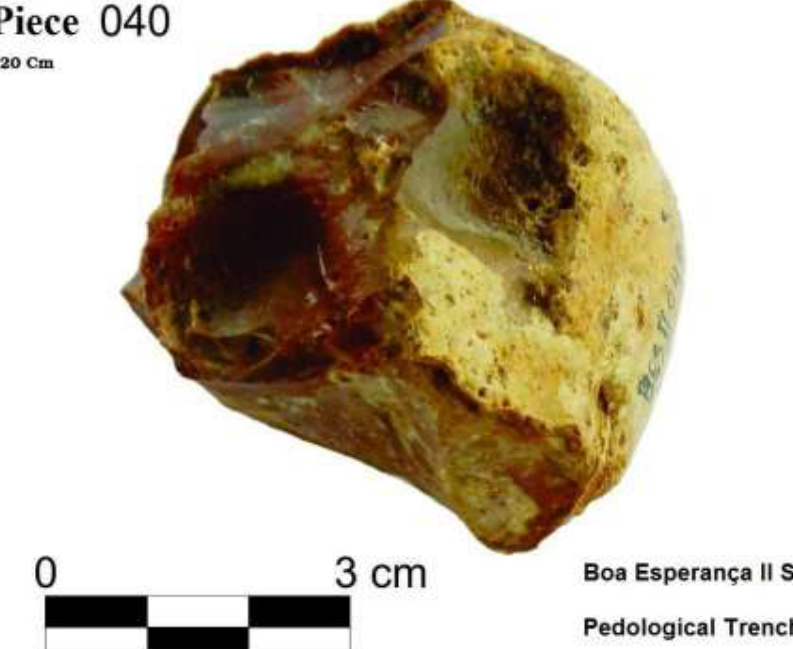
Figure 12. Chert piece with removals and thermic fractures found next to the charcoal sample that was dated to 8.850 to 8.835 years BP by calibrated dating (Beta Analytic). Source: image created by Santos (2018), and charcoal sample sent to the laboratory by